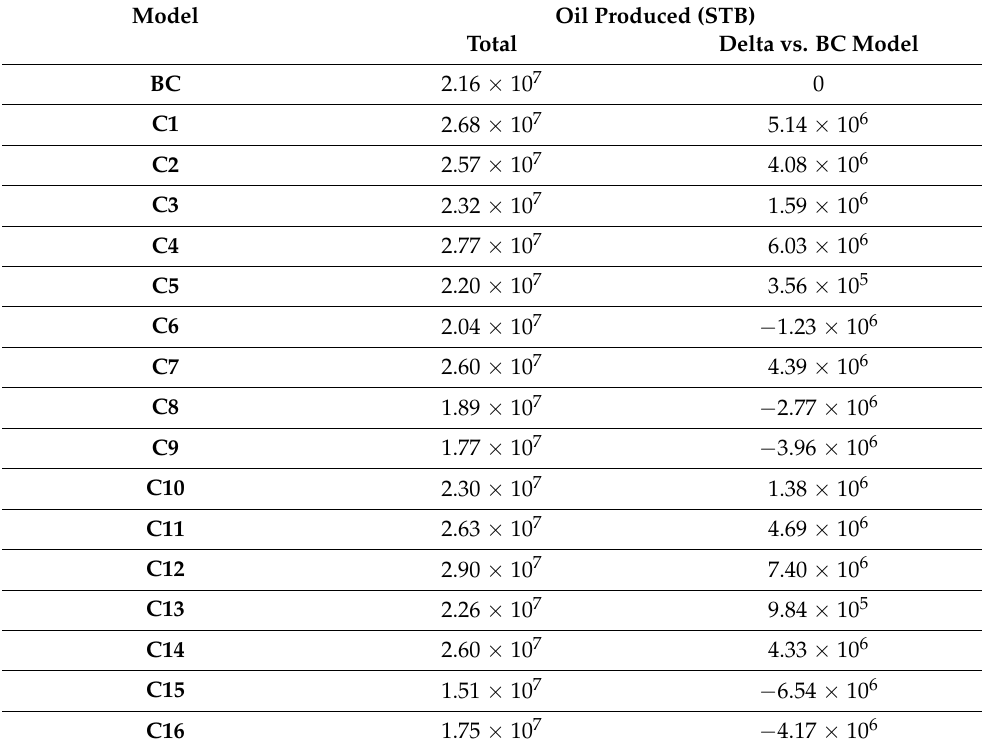
Table 4. Table shows the forecasted total oil produced for each simulation case and the magnitude of difference when compared to the Base Case (BC)